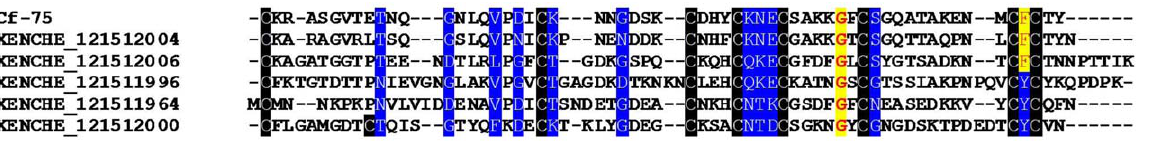
Figure 6. The short flea salivary peptide. ClustalW alignment indicating the cysteine residues in black background, the identical amino acids in yellow background, and the conserved amino acids in blue background. The signal peptide region is not shown. The sequences identified in this work are named Cf- followed by the number of the originating contig from File S1. The sequences derived from GenBank are recognized by the first three letters of their genus name, followed by the first three letters of the species name, followed by the gi| accession